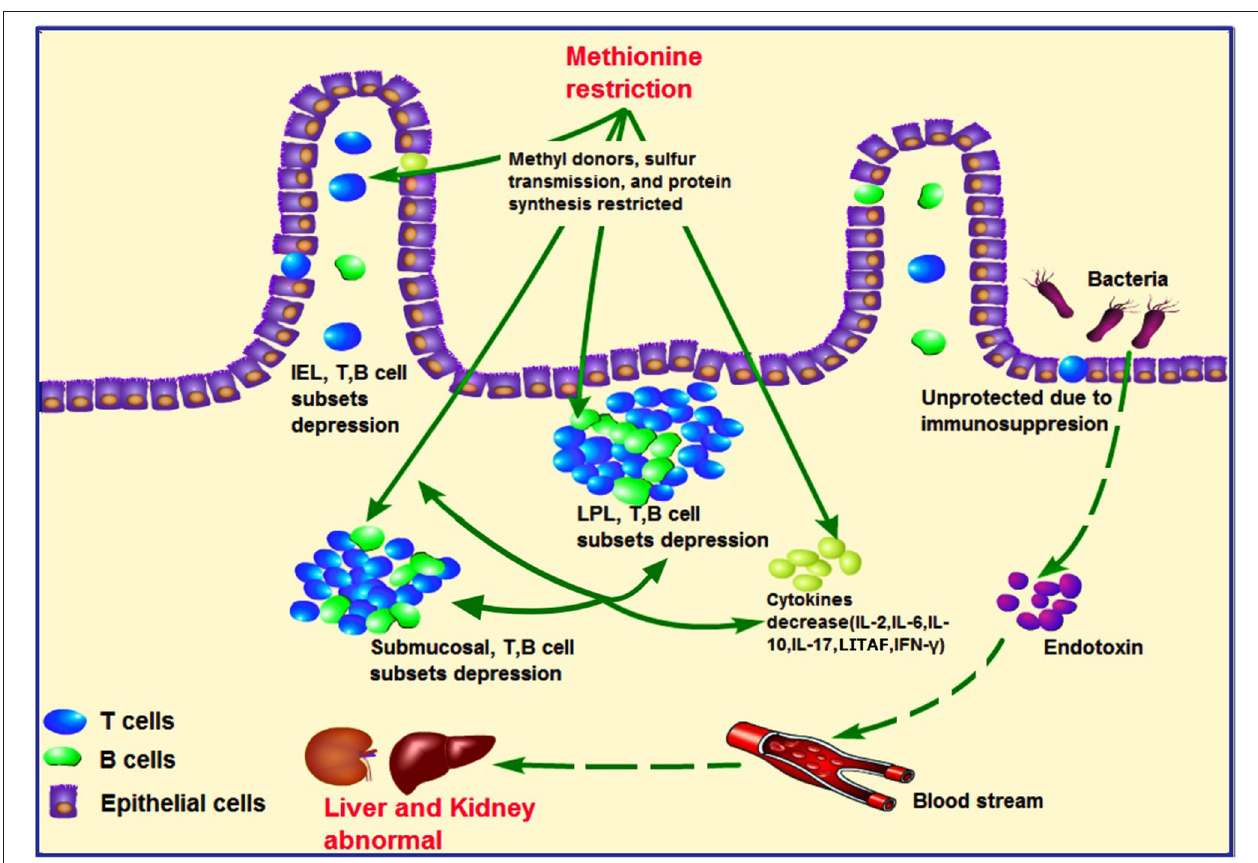
FIGURE 7 | Hypothesized pathology of methionine deficiency in ileum mucosal immunity, and the latent pathway of liver and kidney injury. Methionine, an important methyl donor and source of sulfur, might influence protein synthesis and affect intestinal immunity. Under methionine deficiency, IELs and LPLs and submucosal T- and B-cell subsets were suppressed, which could be partially responsible for decreased levels of cytokines such as IL-2, IL-6, IL-10, LITAF, and IFN- γ . These phenomena contribute to ileum mucosal immunosuppression. As intestinal immunity plays a central role in the gut – liver – kidney axis, uncontrolled harmful bacteria might lead to abnormal liver and kidney function due to secretion of endotoxins. IELs, intraepithelial lymphocytes; LPLs, lamina propria